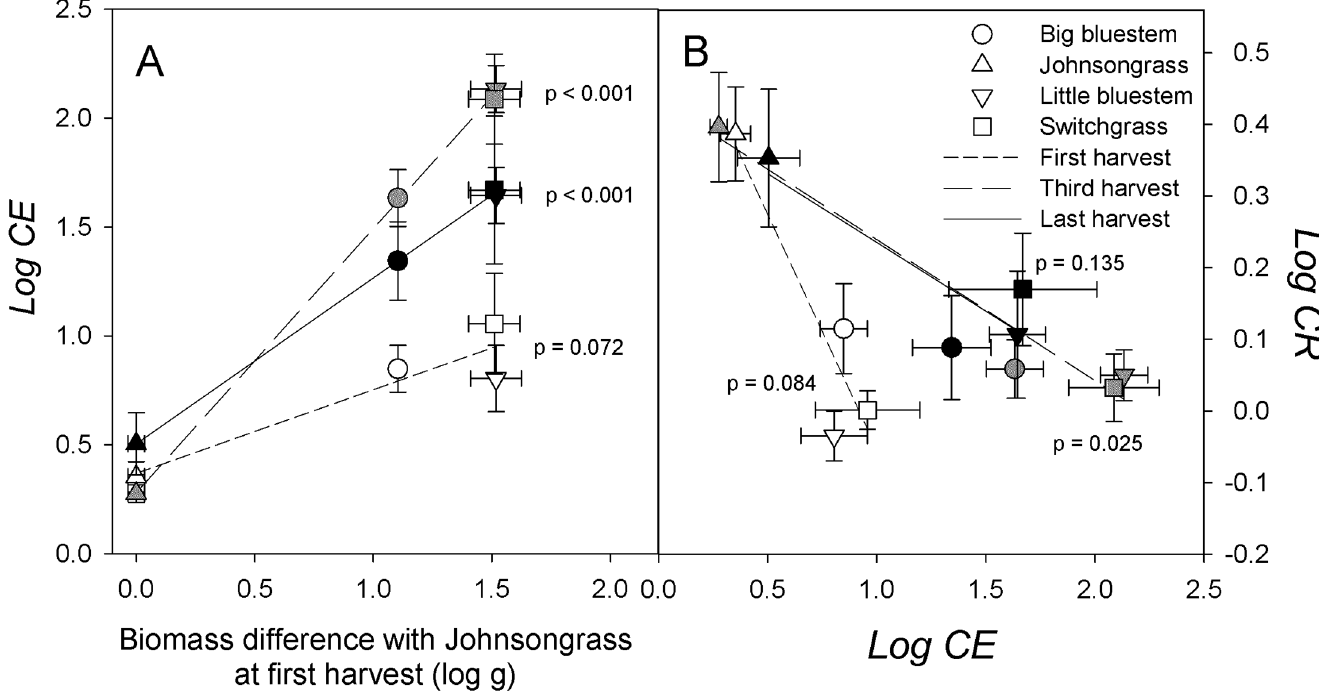
Fig 3. A: Competitive effect ( log CE ) as a function of the log biomass difference between single plants and the averageof Johnsongrass at the first harvest. B: Competitive response ( log CR ) as a function of competitive effect ( log CE ). Shownare pooledmeans across fertilizer levels. Error bars reflect one standarderror of the mean. Regressions were conductedon speciesmeans and the p-values correspond to the regression model slope. For improvedclarity, regressionsfor the second harvest were omitted.